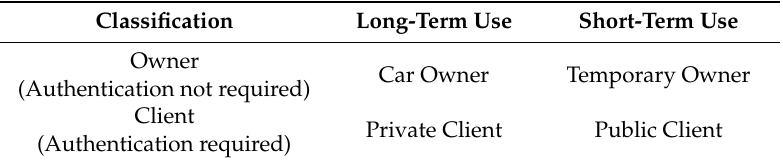
Table 2. User types in C-IVI system.